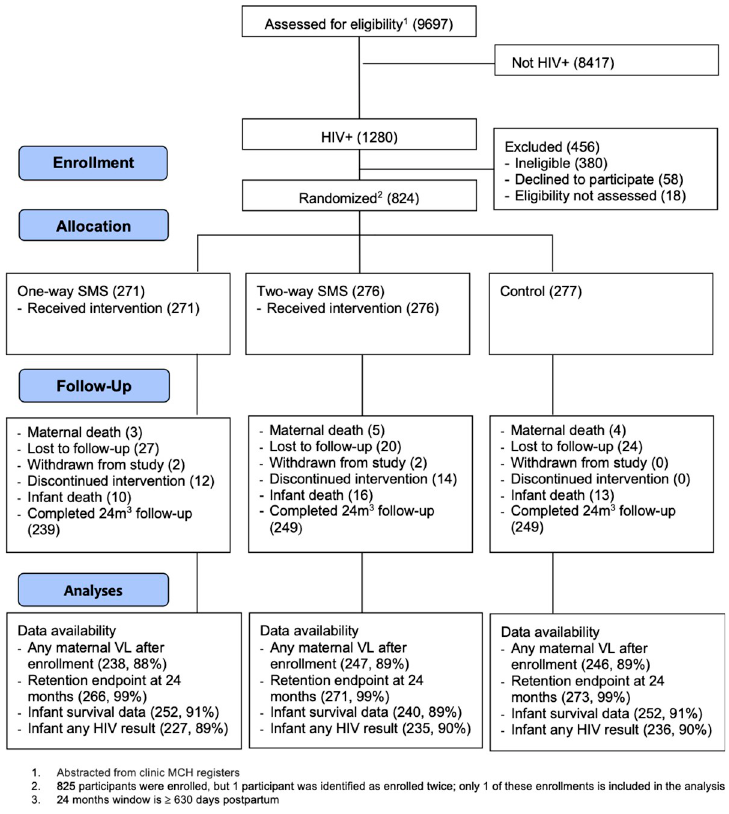
Fig 1. Participant flowchart. MCH, maternal child health; SMS, short message service; VL, viral load.